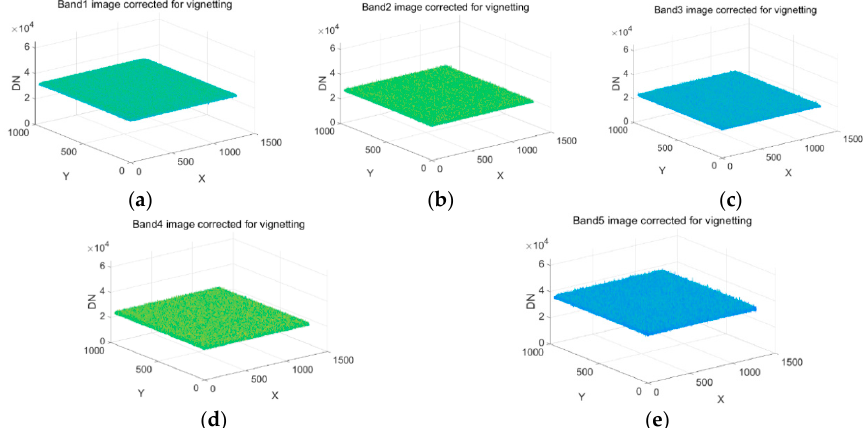
Figure 13. Results of vignetting correction for various band images: ( a ) Band1 image; ( b ) Band2 image;